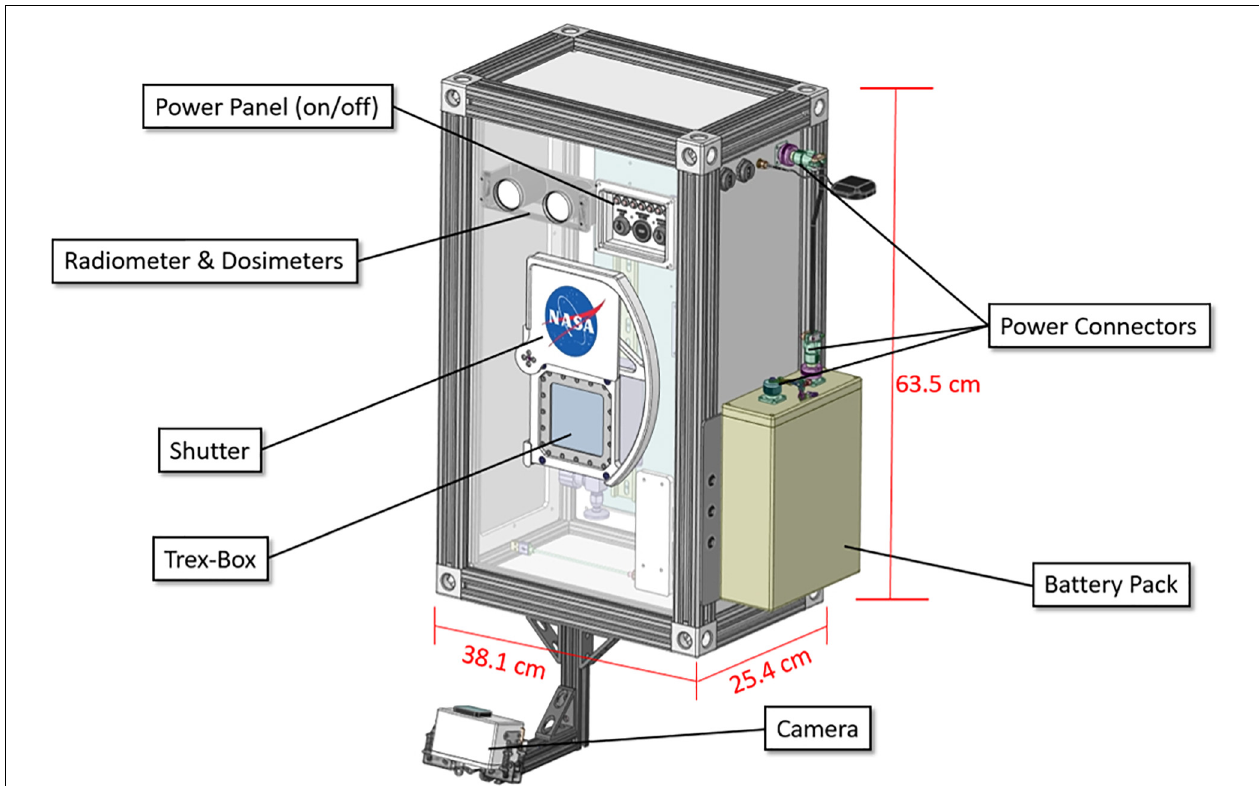
FIGURE 2 | MARSBOx payload labeled model.